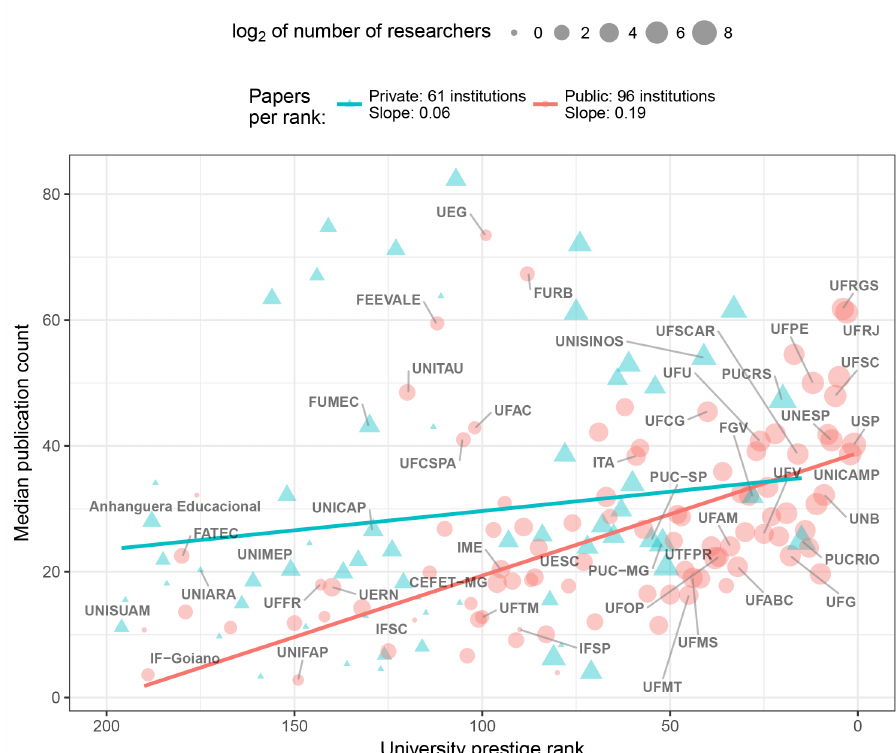
Figure 5 - Median publication count of doctorates correlated with institution prestige. Points indicate the median number of publications adjusted for inflation. Lines are robust linear regressions (Venables and Ripley 2002) weighted by the number of researchers in each institution. This kind of linear regressions provided by package MASS in R project is used to avoid outliers and follow tendencies according to the number of researchers in each